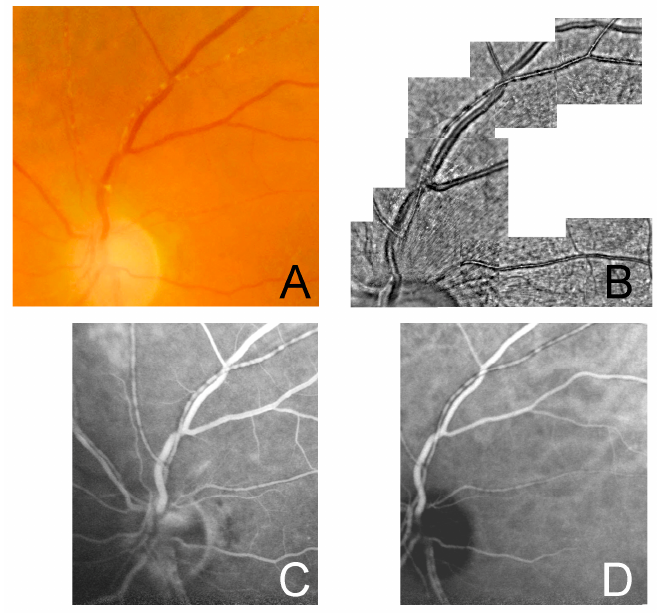
Figure 3. Multimodal imaging of case 3. A 79-yo female with VZV-related acute retinal necrosis confirmed with RT-PCR analysis on aqueous tap (1,255,340 genomes/mL), imaged two months after treatment with intravenous acyclovir 10 mg/kg three times daily and subsequent oral valacyclovir 1 g three times daily. ( A ) FP showing wide multifocal arterial involvement with a segmented pattern; ( B ) AO confirms the presence of KP as segmental hyporeflectivity in multiple sectors of the arterial vascular branches; ( C , D ) late phase hypofluorescent vascular lesions are seen on FA and